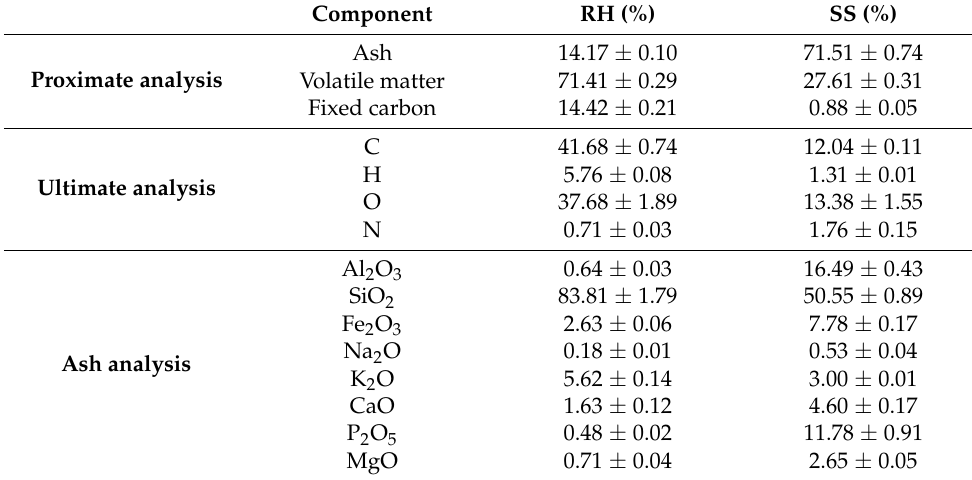
Table 1. Typical characteristics of raw